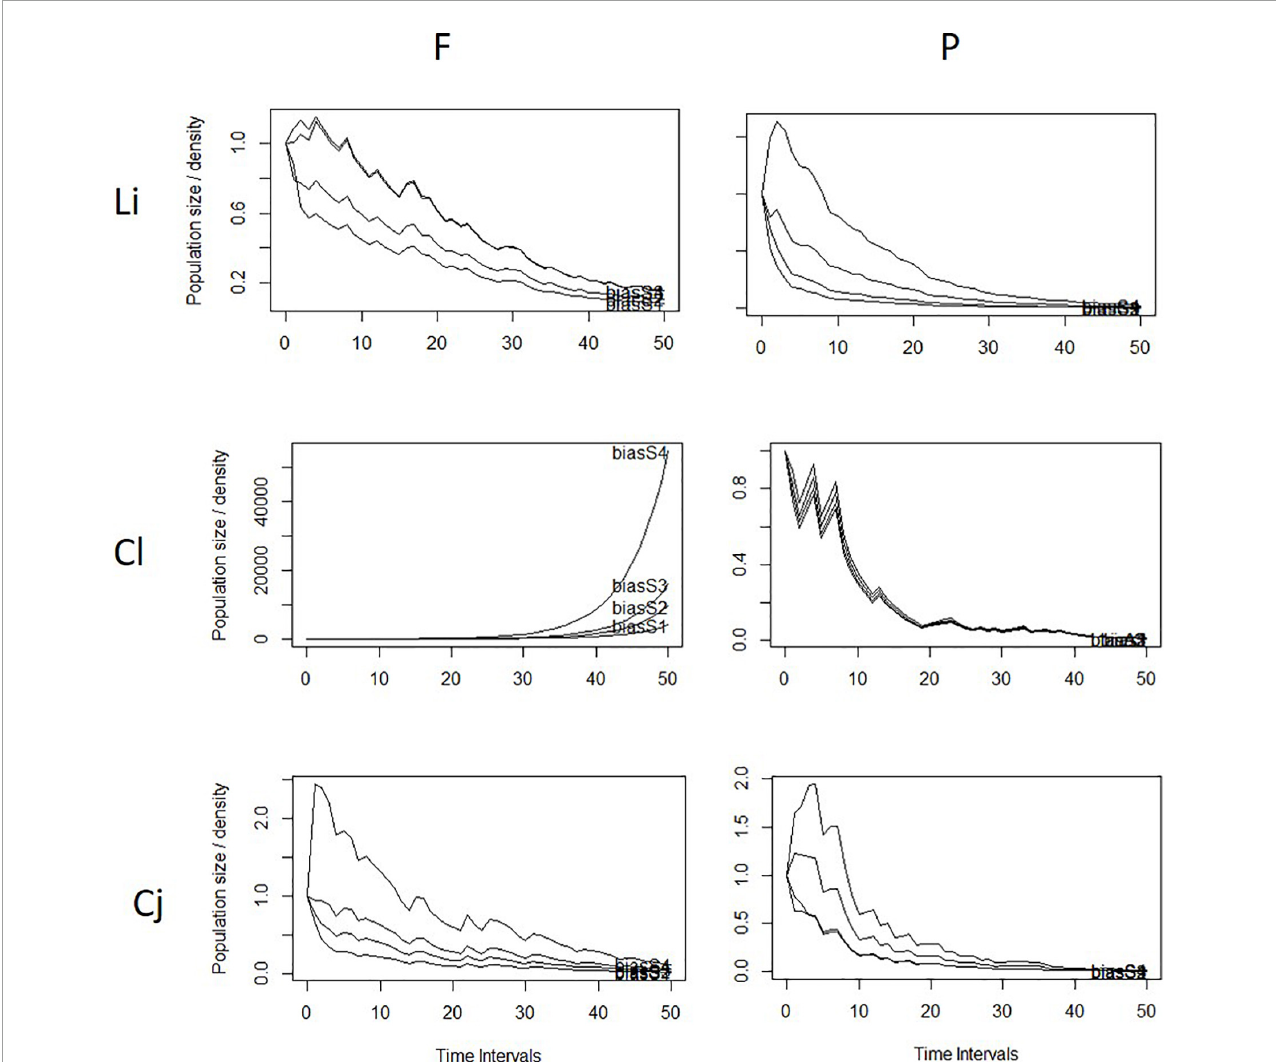
FIGURE5 Rodriguezia granadensis transient dynamic simulation for 50 seasons, 25 years for tree of six study sites, Li, Lilas; Cl, Calibío; Cj, Cajibío. Subsites: F, forest; P, pasture. Bias S1, S2, S3, S4, stage-biased demographic